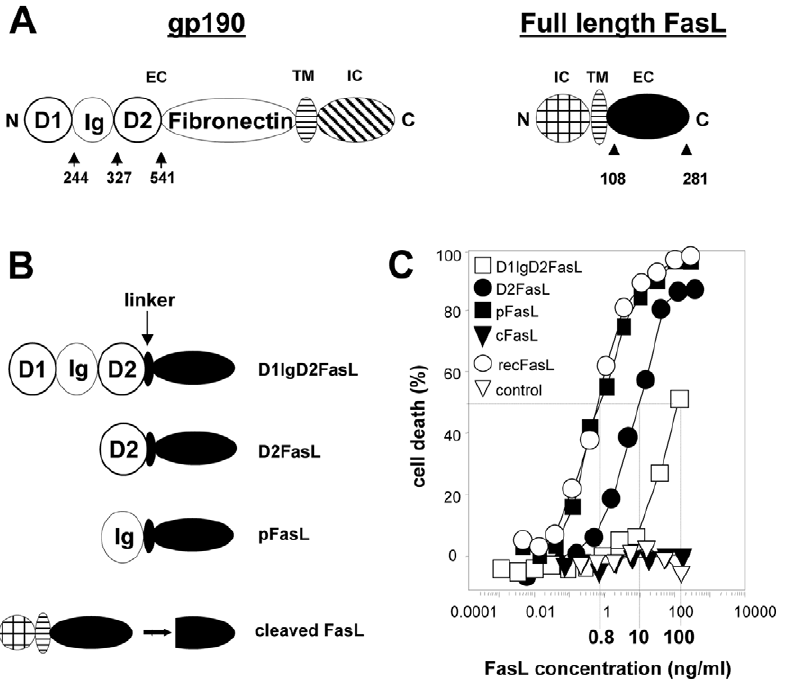
Figure 1. Obtention and functional characteristics of the FasL/gp190 chimeras. Panel A: Modules constituting gp190 and FasL are depicted as mature proteins. EC, TM and IC represent the extracellular, transmembrane and intracellular domains, respectively. N and C represent the N- and C-terminal ends. The numbers depict the domain boundaries used to create the chimeras. Cleaved FasL (cFasL) is spontaneously generated by a metalloprotease cleaving between aminoacids 126 and 127. Panel B: Representation of the cFasL and the gp190/FasL chimeras. Panel C: Serial dilutions of supernatants from COS cells transfected with the FasL constructs or the empty vector (control) were incubated with Jurkat cells. Cell death was measured using the MTT assay. As a positive control, we used the commercially available antibody-cross-linked FasL (recFasL). Calculated C50 are indicated on the graph. Results from one representative experiment out of 5 are depicted.